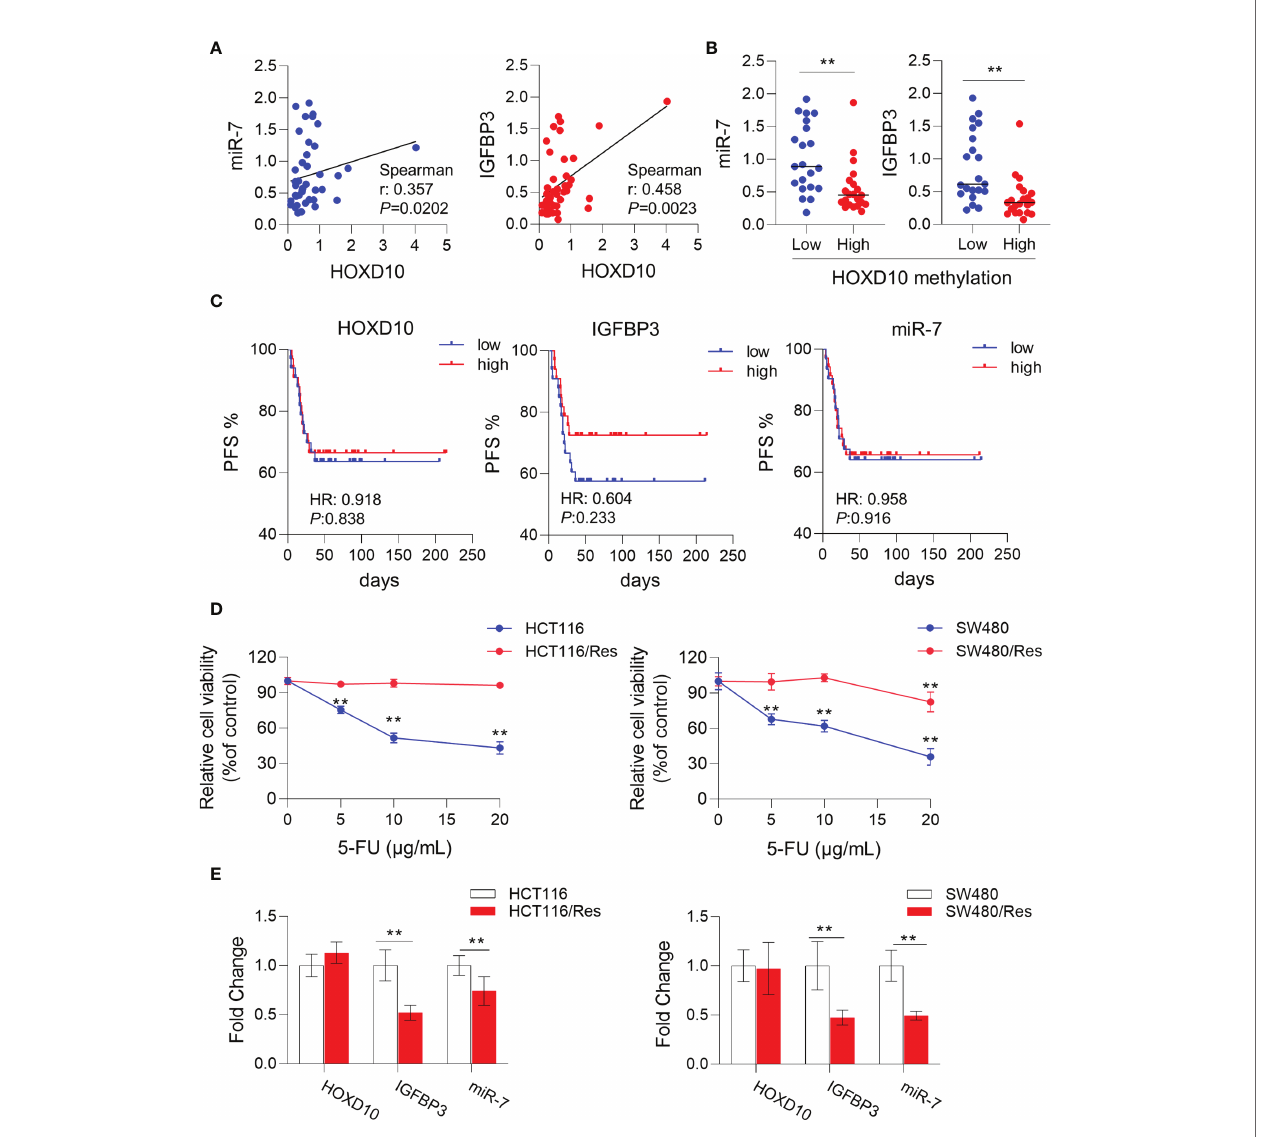
FIGURE 5 | HOXD10 and its targets miR-7 and IGFBP3 were correlated with 5- fl uorouracil (5-FU)-resistant in colorectal cancer. (A) Correlation of the expressions of HOXD10 and its targets, miR-7 and IGFBP3. (B) Correlation of HOXD10 methylation and the expression of either miR-7 or IGFBP3. ** p < 0.01 (Mann – Whitney test). (C) Correlation of HOXD10 , miR-7, and IGFBP3 with progression-free survival in stage II and III CRC patients ( n = 66) treated with adjuvant 5-FU-based chemotherapy using a publicly available GEO dataset (GSE103479). (D) CCK-8 assay showed the cell viability of 5-FU-resistant cell lines, HCT116/Res and SW480/Res, and their parental cells in the presence of 5-FU at different concentrations. ** p < 0.01 (independent t -test comparing parental and 5-FU-resistant cells). (E) Relative expressions of HOXD10 , miR-7, and IGFBP3 in parental and 5-FU-resistant cells by qPCR. ** p < 0.01 (independent t -test comparing parental and 5-FU-resistant